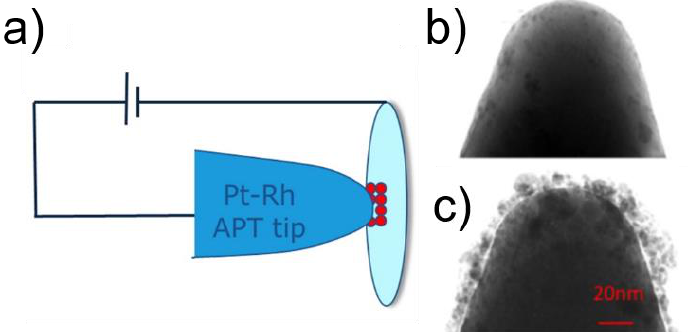
Figure 6. Sample preparation by electrophoresis. ( a ) Schematic principle of the deposition method; ( b ) Transmission Electron Microscopy (TEM) image of a Pt specimen before deposition and; ( c ) TEM image of the same Pt specimen after deposition of Ag@Pd nanoparticles. Panel ( a ): Reprinted with permission from [121]. Copyright (2014) American Chemical Society. Panels ( b , c ): Reprinted by permission from Nature: [120], Copyright (2011).